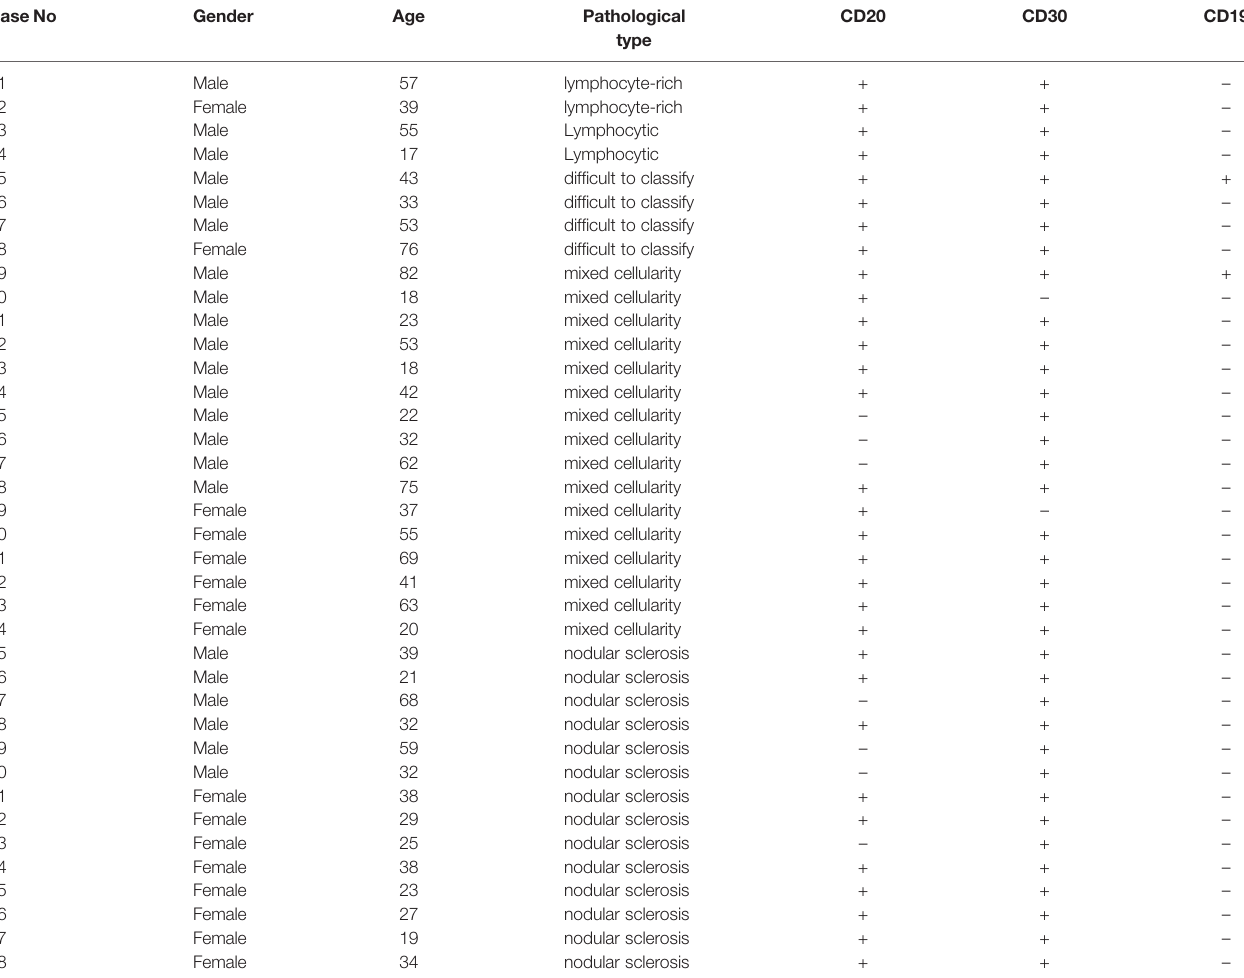
“ + ” Indicates positive expression in Reed-Sternberg (RS) cells ; “ - ” Indicates no expression in Reed-Sternberg (RS)